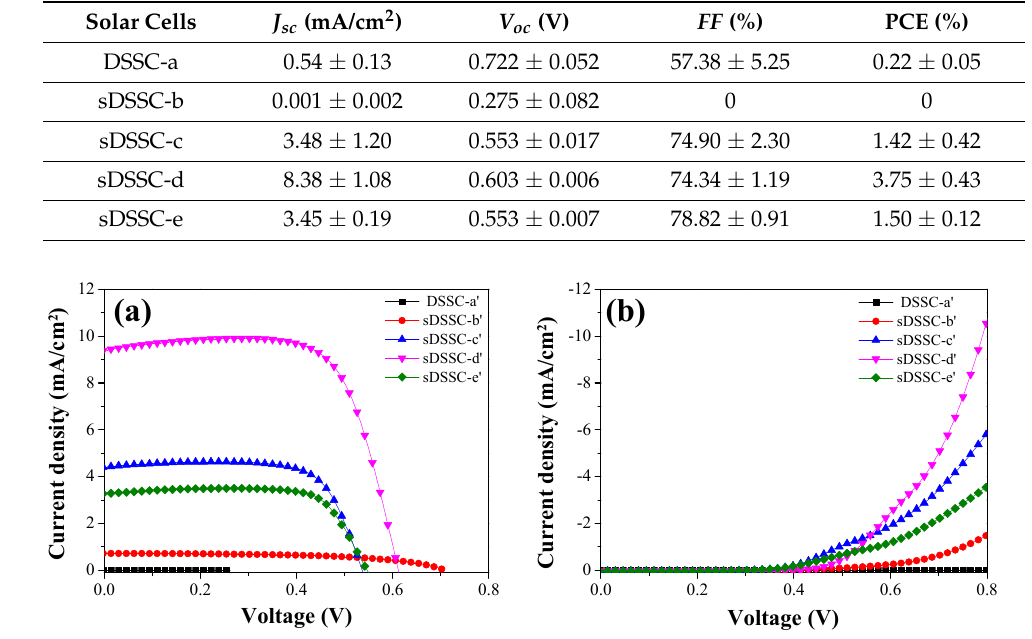
Figure 3. J–V characteristics ( a ) and dark-current ( b ) curves for the champion devices with MPII, m-MTDATA, or solidified MPII layer with or without additives. Table 4. Photovoltaic performance of champion cells with MPII, m-MTDATA, or solidified MPII layer with or without additives.